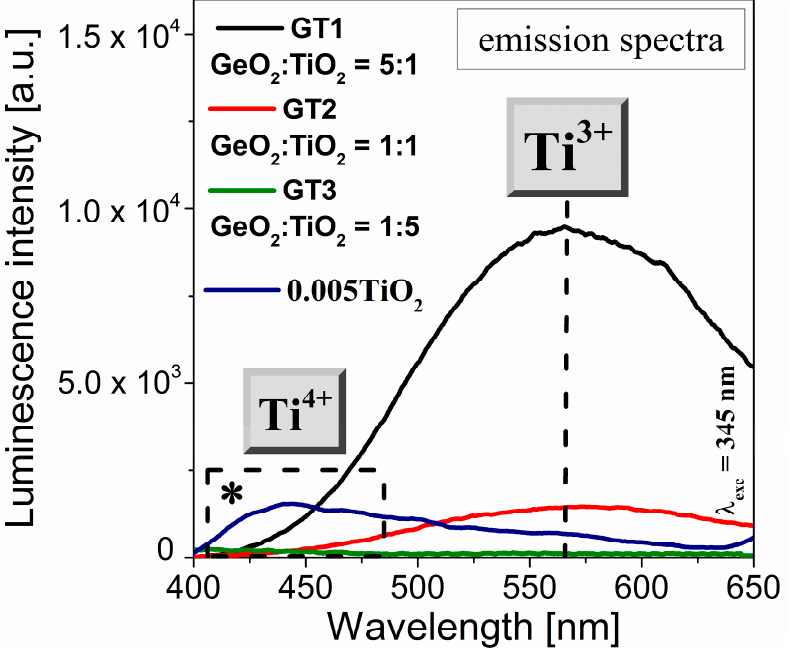
Figure 7. Visible emission spectra ( λ exc = 345 nm) for GT1, GT2, and GT3 samples. The asterisk (*) refers to glass containing an extremely low titanium dioxide concentration.